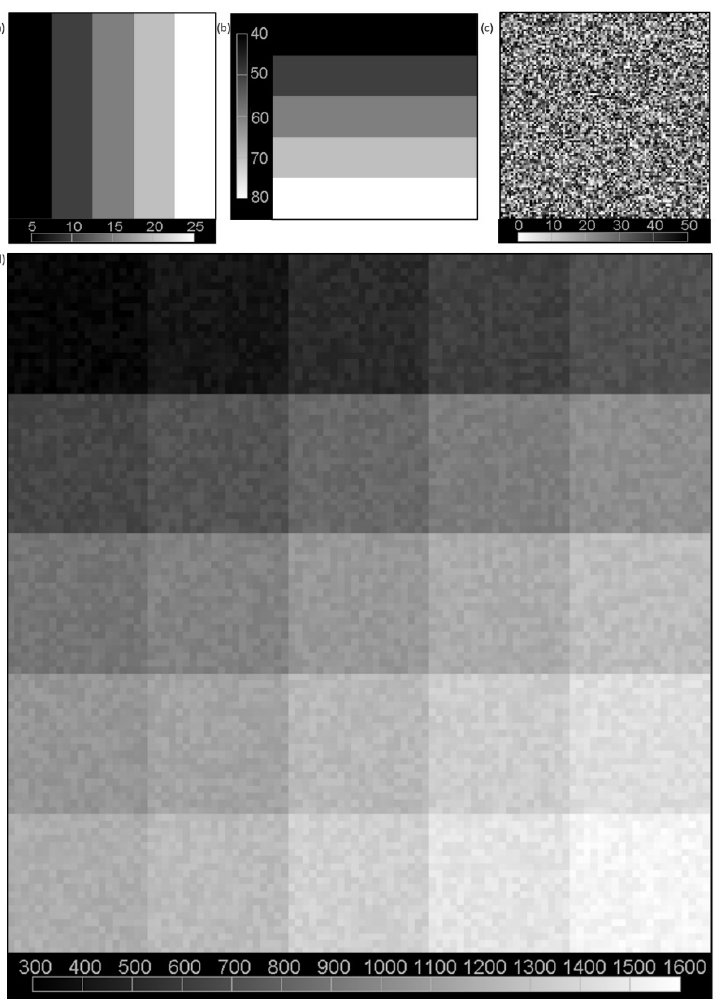
Figure 2. Simulated signal intensity with biexponential decay for TE = 9 ms. The signal intensity was created from two constant-amplitude components 1200 and 1800: ( a ) short T2 component with values of 5, 10, 15, 20, and 25 ms; ( b ) long T2 component with values of 40, 50, 60, 70, and 80 ms; ( c ) noise (level was set to 50); and ( d ) the simulated image consisting of 25 subimages (20 × 20 pixels).